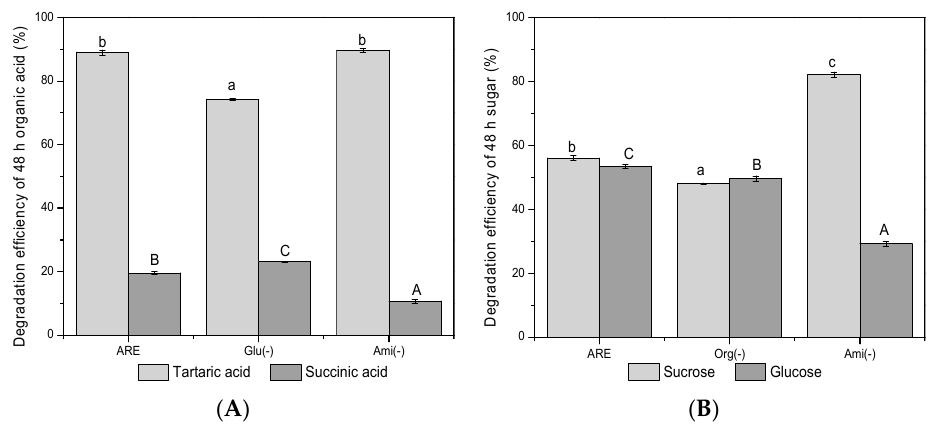
Figure 3. Mean degradation efficiency of artificial exudates during 48 h experiments: ( A ) tartaric acid and succinic acid; ( B ) sucrose and glucose. A, B, C, and a, b, c, indicate significant differences among the three treatments ( p < 0.05).